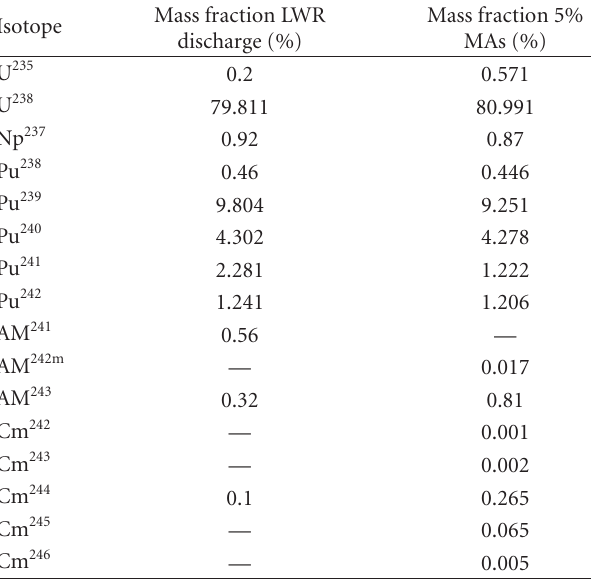
Table 1: Core isotopic compositions considered